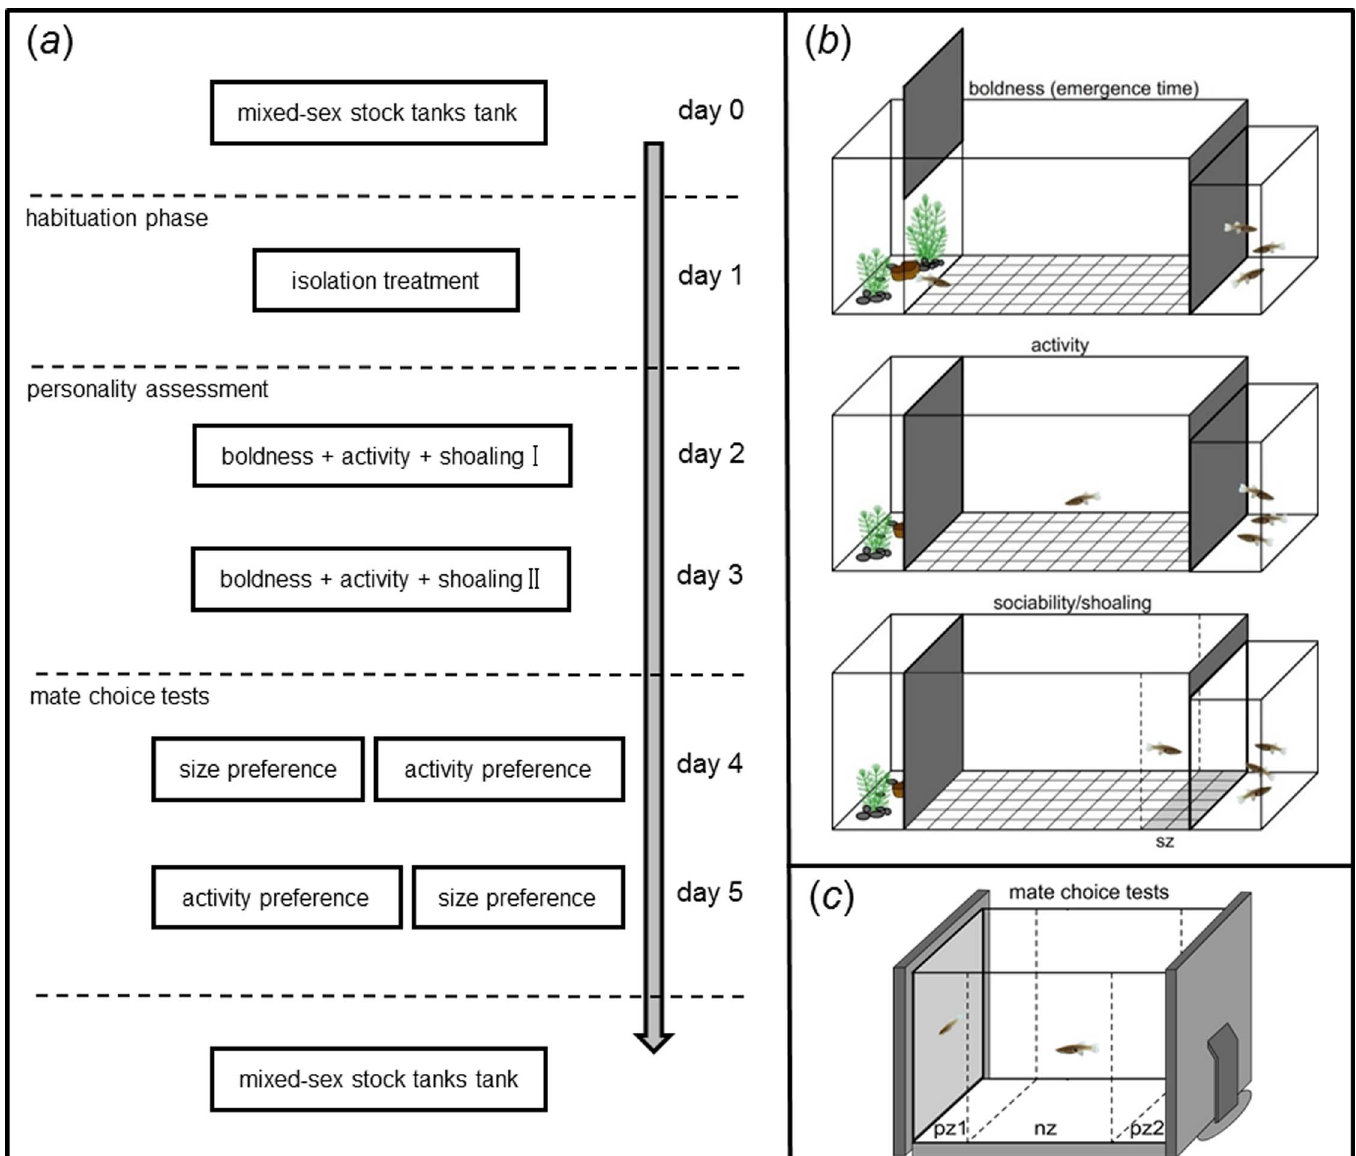
Fig 1. Experimental timeline and schematic view of the experimental set-ups. ( a ) Experimental timeline and ( b ) schematic view of the experimental set-ups used to assess three behavioral measures that are widely used to assess animal personality, namely boldness (assessed as the time focal fish needed to leave the starting zone after the trapdoor was opened), activity (numbers of squares crossed) and sociability/shoaling (time spent in proximity of the stimulus shoal after a divider was removed that had blocked visual contact between the test subject and the stimulus shoal). sz , shoaling zone. ( c ) Experimental set-up used to assess focal individuals’ mating preferences as times spent near two monitors showing animated stimulus fish. pz1 , pz2 , preference zones; nz , neutral zone.